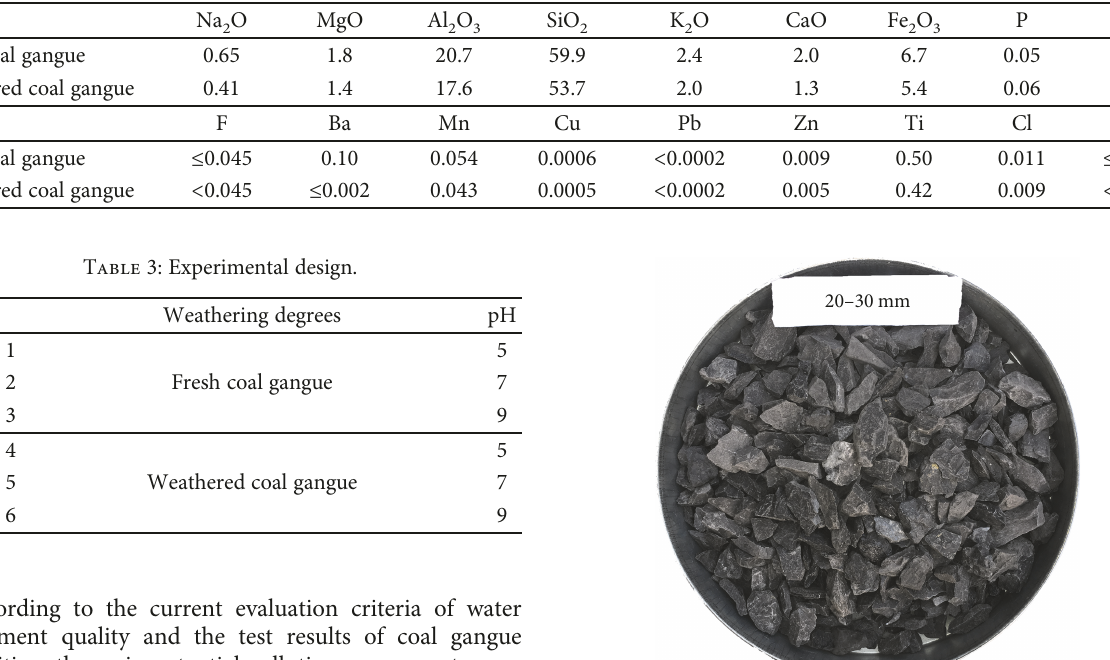
Table 2: Chemical composition of coal gangue (%).